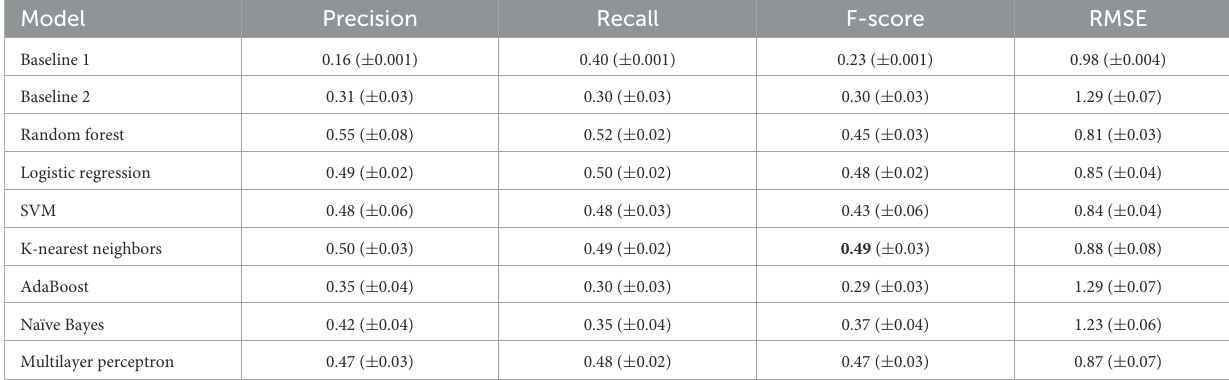
TABLE 5 Results of 5-class engagement level classification (standard deviation in